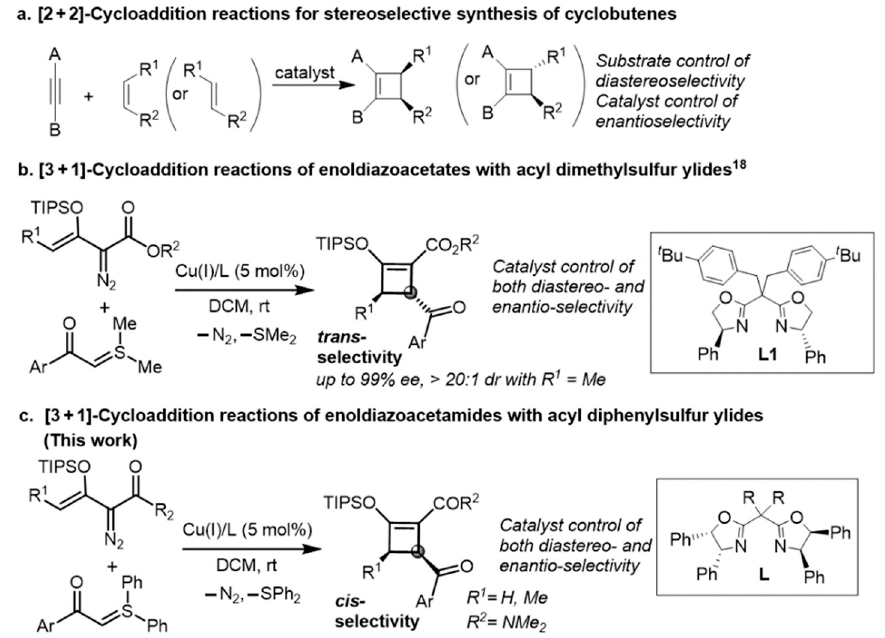
Figure 1. Cycloaddition reactions that form cyclobutene derivatives: ( a ) [2 + 2]-cycloaddition; ( b ) [3 + 1]-cycloaddition of silyl group-protected enoldiazoacetate esters; ( c ) [3 + 1]-cycloaddition of silyl group-protected enoldiazoacetamides (this work).